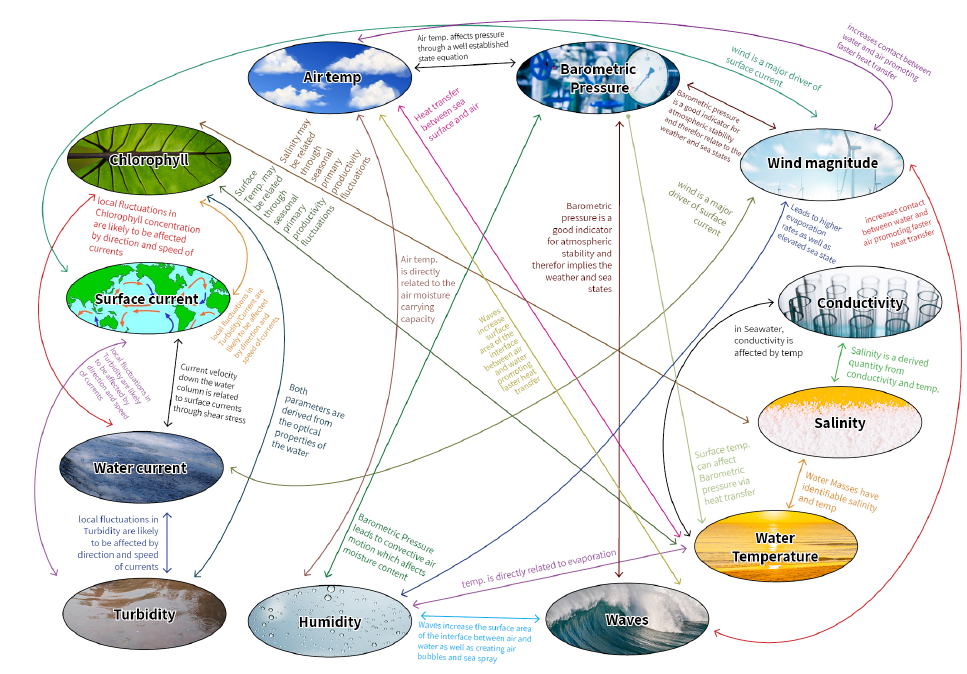
Figure 2. Dependencies between datasets measured in